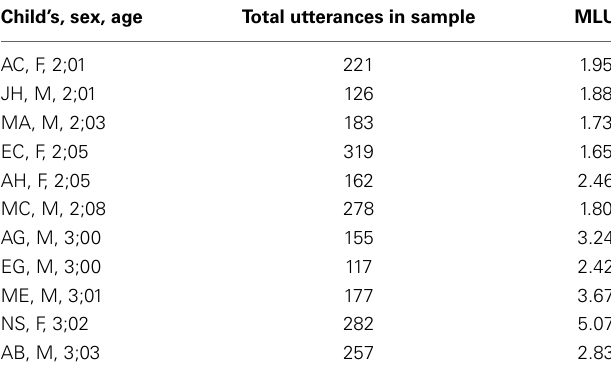
Table 4 | Number of utterances and MLU for monolingual Basque-speaking children.